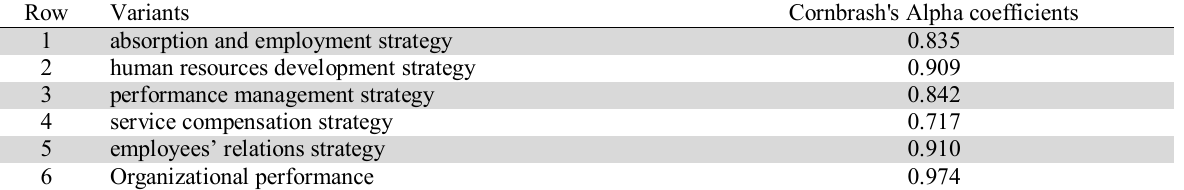
Cornbrash's Alpha coefficients of the questionnaire per study variants